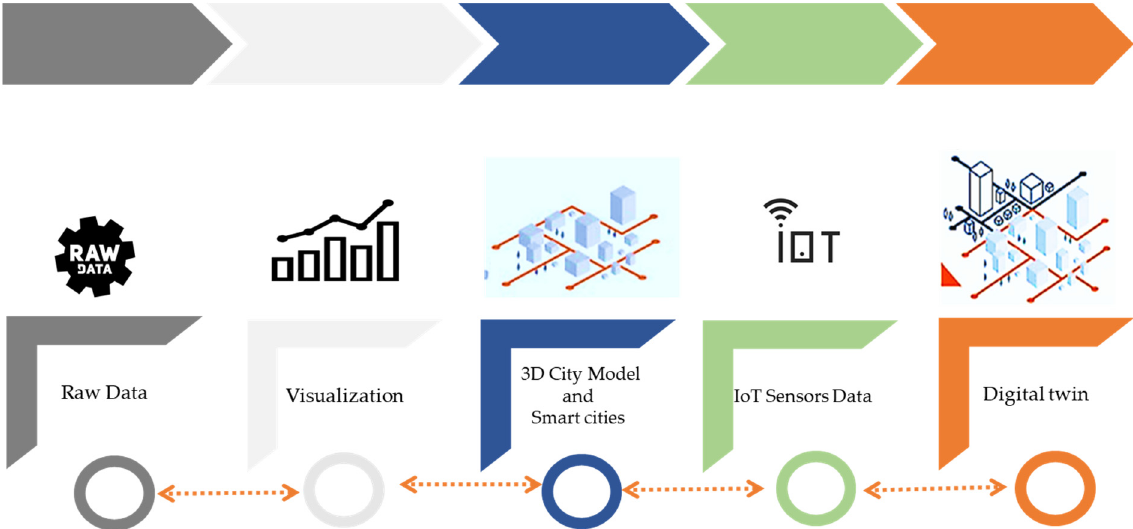
Figure 8. Step-by-step representation of article outline for the development of a digital twin technology for smart cities.